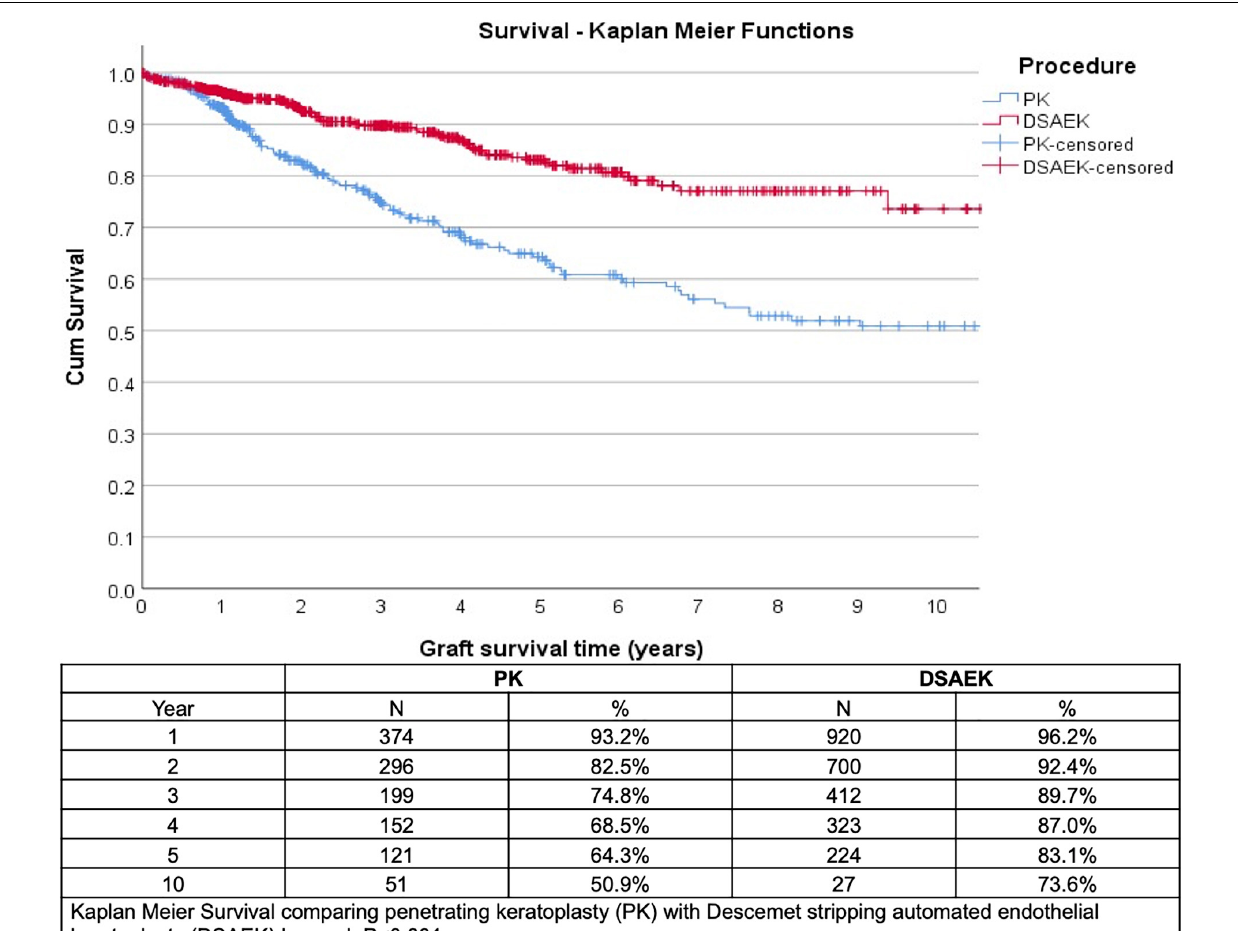
FIGURE 1 | Kaplan–Meier graft survival curves demonstrated superior 5- and 10-year graft survival comparing Descemet stropping automated endothelial keratoplasty (DSAEK) to penetrating keratoplasty (PK), N = number of grafts analyzed (log-rank P -value <